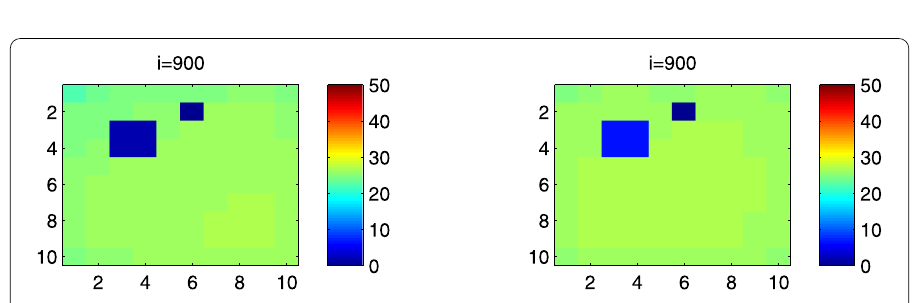
Figure 16 R Cpq behavior at the final instant i = 900 in the presence of optimal controls characterized in (11) with a travel-blocking vicinity optimal control strategy followed in the two patches P and P (cid:2) = { C 26 } . On the left side, the case when the disease starts from the corner cell C 1010 . On the right side, the case when the disease starts near the center of (cid:2) , exactly at C 65 .